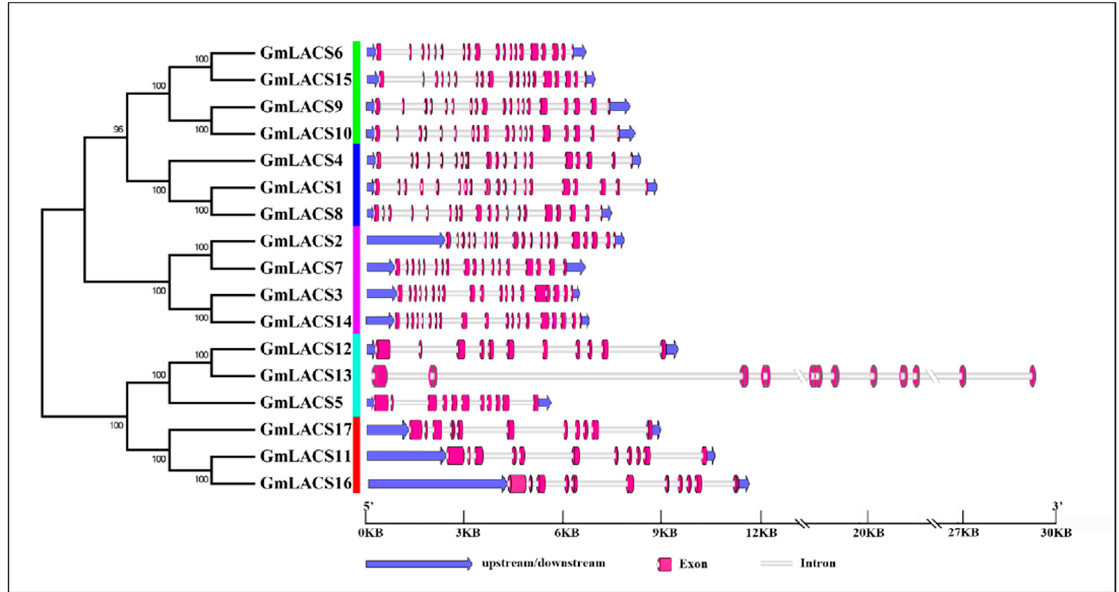
Figure 2. Gene structure analysis of GmLACSs . The gene structure was analyzed by sequencing according to subfamilies. The blue arrow was the non-coding region, 5 ′ -3 ′ in the direction of the arrow, the red circle was the exon, and the gray line was the intron. The length of each gene sequence is proportional.